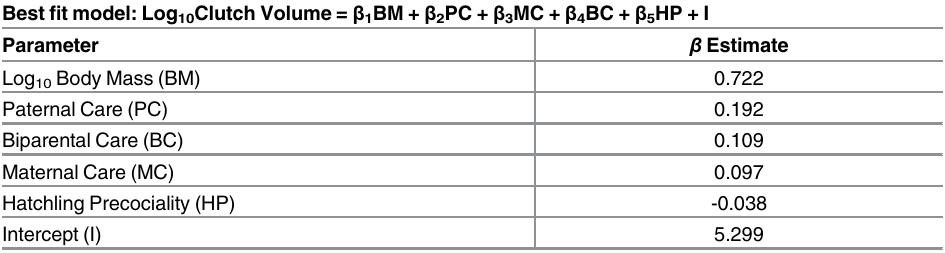
Table 5. Summary of parameter estimates for the best GEE reproductive strategy model.